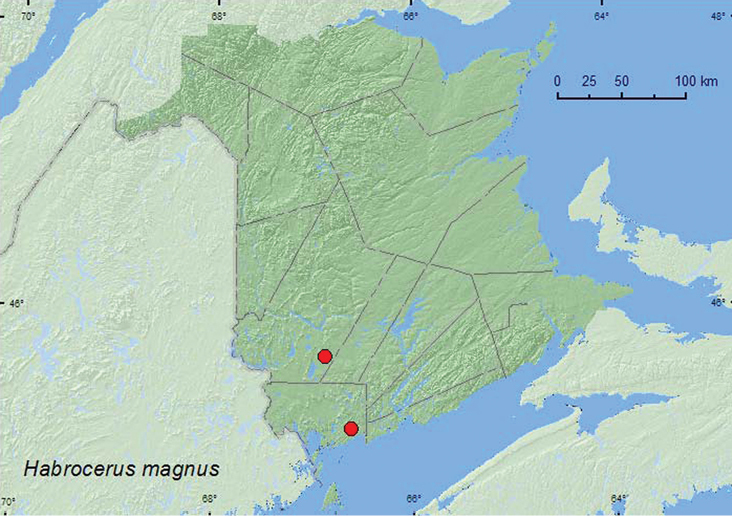
Collection localities in New Brunswick, Canada of Habrocerus magnus.